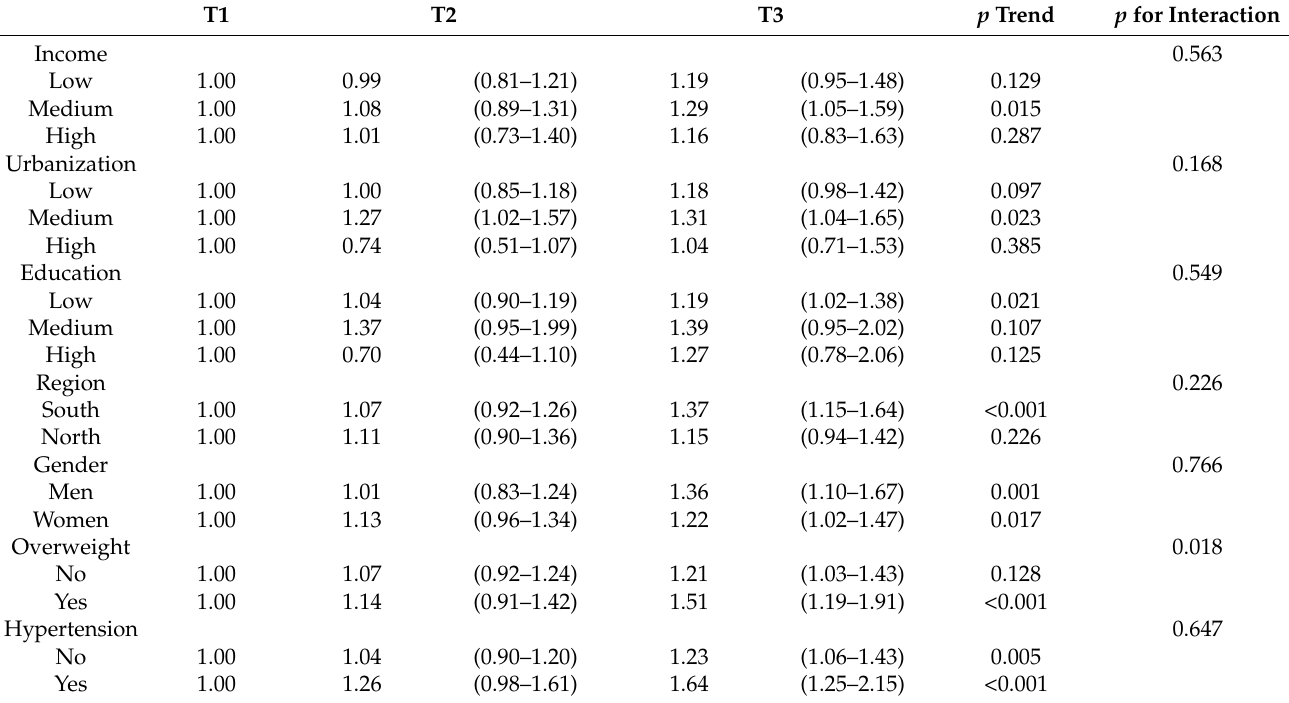
Figure 2. Odds ratios (95% CI) for optimal sleep duration by selenium intake tertiles among Chinese individuals aged 20 or older from China Health and Nutrition Survey. Age, gender, and calorie intake were modified in Model 1. Smoking and alcohol use, income (low, medium, and high), urbanization (low, medium, and high), education (low, medium, and high), and level of physical activity (continuous) were all further accounted for in Model 2. BMI and hypertension were still further modified in Model 3. Self-reported diabetes, fat intake, and energy intake were further modified in Model 4. Table 2. Subgroup analyses of selenium consumption with the optimal sleep in China Nutrition and Health Study ( n =